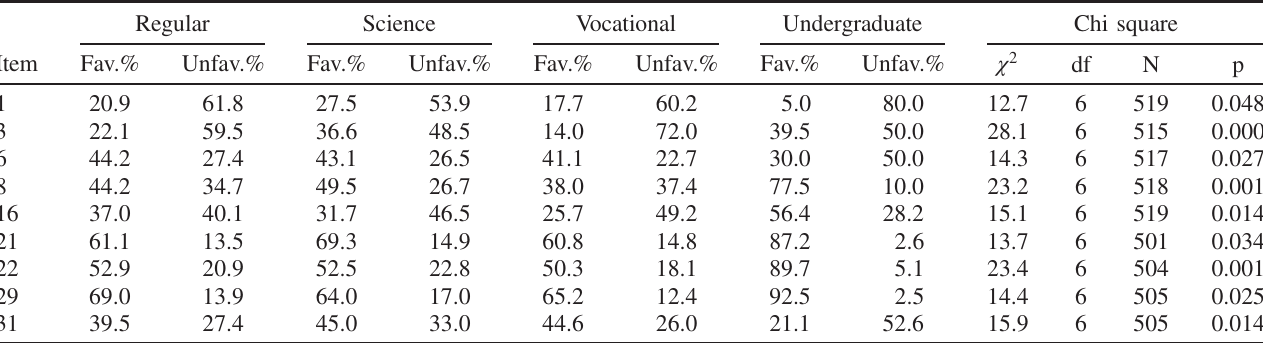
TABLE IV. Percentages of regular, science, and vocational high school students ’ and university students ’ favorable (fav) and unfavorable (unfav) attitudes and approaches to problem solving and the corresponding chi-square statistics for significant items.